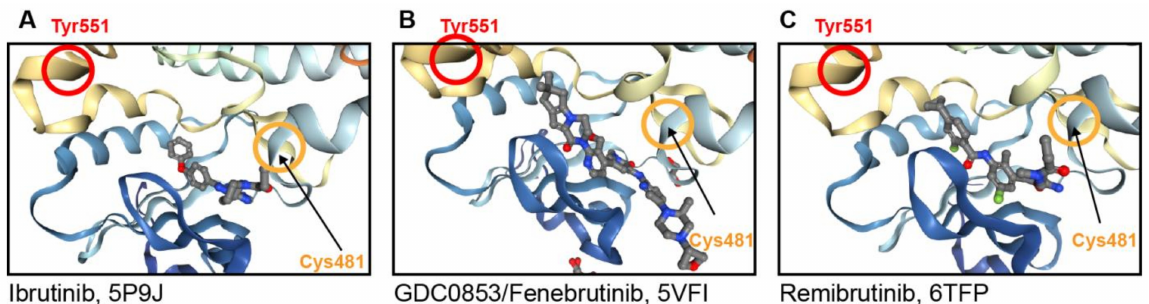
Figure 3. Crystal structures of Btk in complex with inhibitors . Secondary structure cartoons of the catalytic domain of Btk in complex with ( A ) Ibrutinib (PDB entry code 5P9J), ( B ) Fenebrutinib (PDB entry code 5VFI) and ( C ) Remibrutinib (PDB entry code 6TFP). Highlighted are Cys481 (orange circle) and Tyr551 (red circle). Snap shots were visualized using the web-based NGL